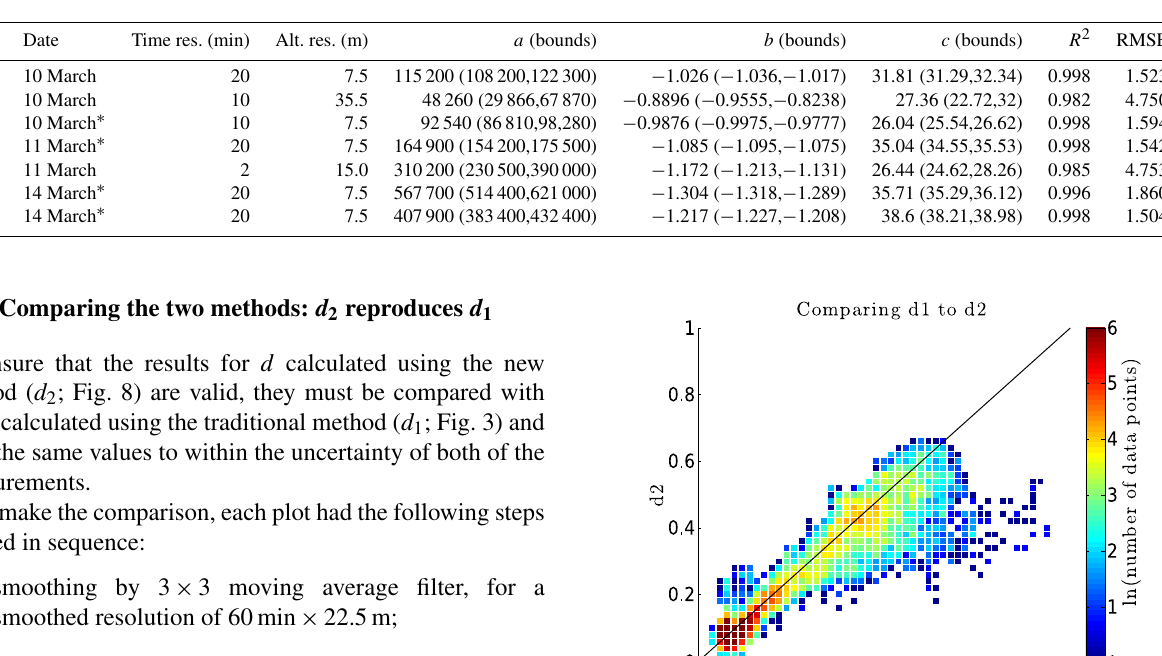
Table 1. Fitting coefficients ( a , b , and c ; fitting a second-order power law of the form y = ax b + c ) and goodness of fit ( R 2 and root mean square error (RMSE)) for various dates, time resolutions (time res.), and altitude resolutions (alt. res.) in March 2013 used for determining calibration function Y(z) . Days marked with ∗ used only a portion of the data available for that day: clear sky or thin clouds only.